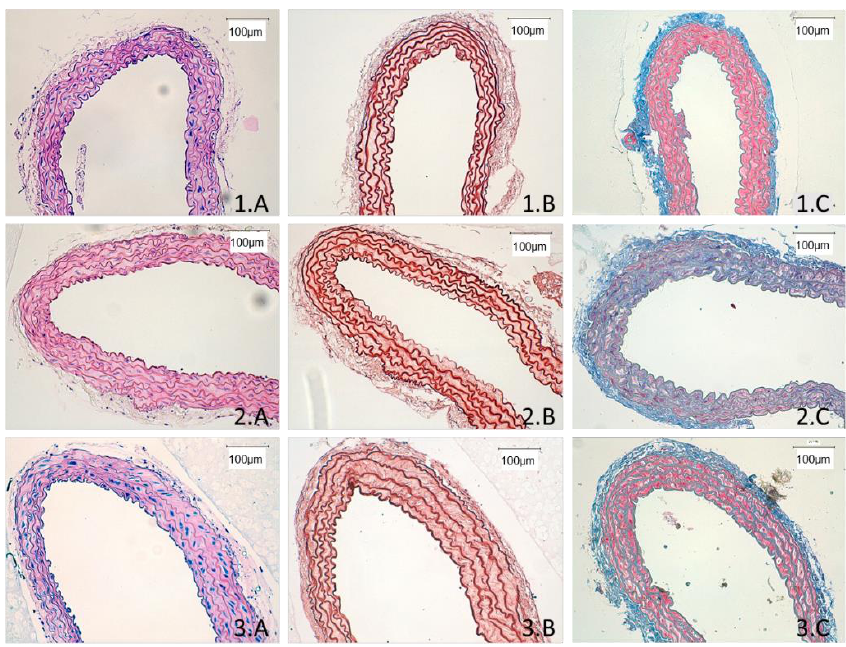
Figure 5. Aortic wall thickness for all groups studied. Results are means ± SD ( n = 8 – 10 per group). **** p < 0.0001.